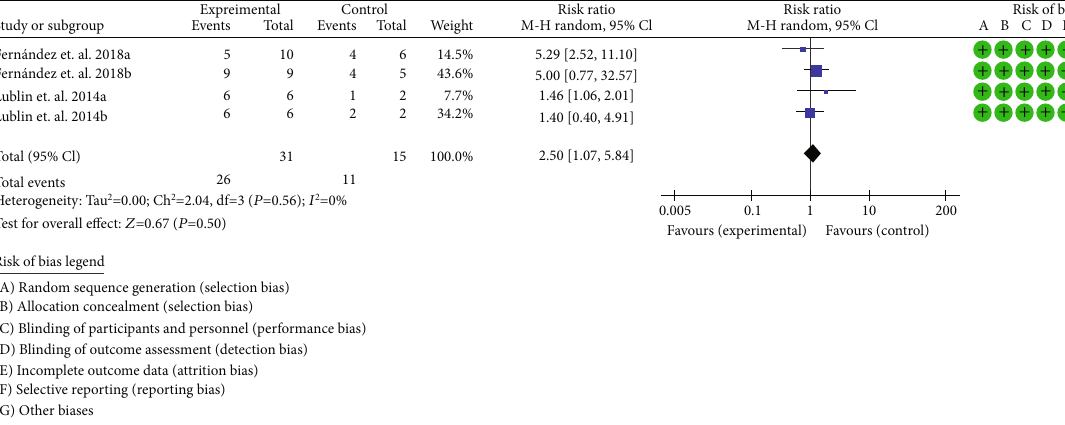
Figure 13: Adverse events of multiple sclerosis (CI: con fi dence